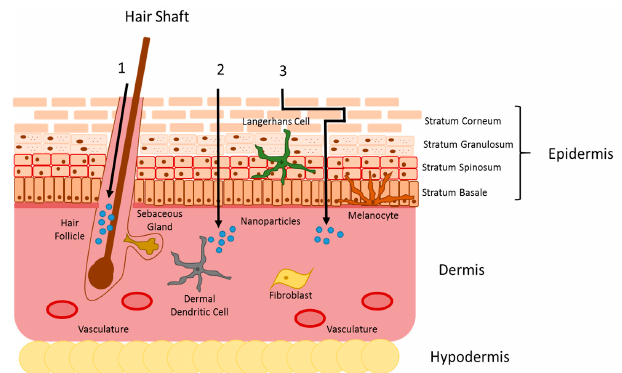
Figure 1. Illustration of nanoparticle skin penetration pathways. Topically applied nanoparticles can penetrate the skin in one of three different ways: ( 1 ) through the appendageal route, ( 2 ) through the intracellular route, or ( 3 ) through the intercellular route. The appendageal route involves nanoparticles entering hair follicles, sweat glands, or skin furrows for either penetration to the dermis or retention for increased drug release. The intracellular route involves a direct path through the cell membrane of multiple layers of the epidermis. The intercellular route involves a more tortuous path between epidermal cells. The pathway taken likely depends on the nanoparticle size, charge, morphology, and